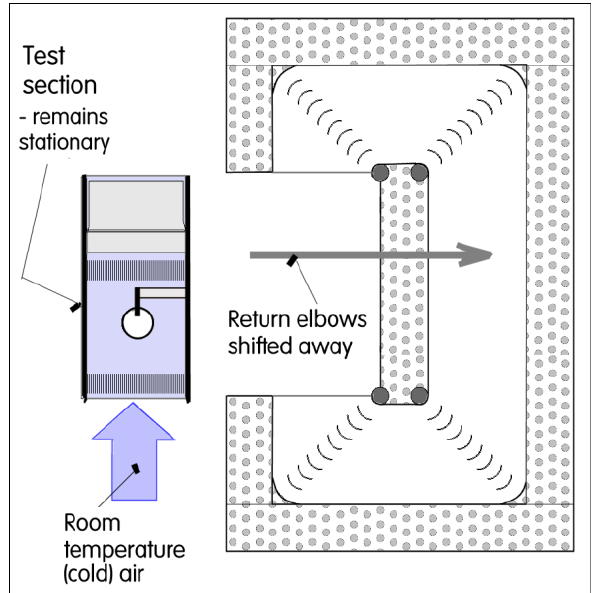
Fig. 18. Operation of the wind tunnel in the sample solidifying test. At the start of the cooling run the whole return-flow part of the tunnel is shifted away while the test section remains in place and is fed by cold air from the room. The stationary position of the test section is necessary for retaining properly focused cameras and lights (also not